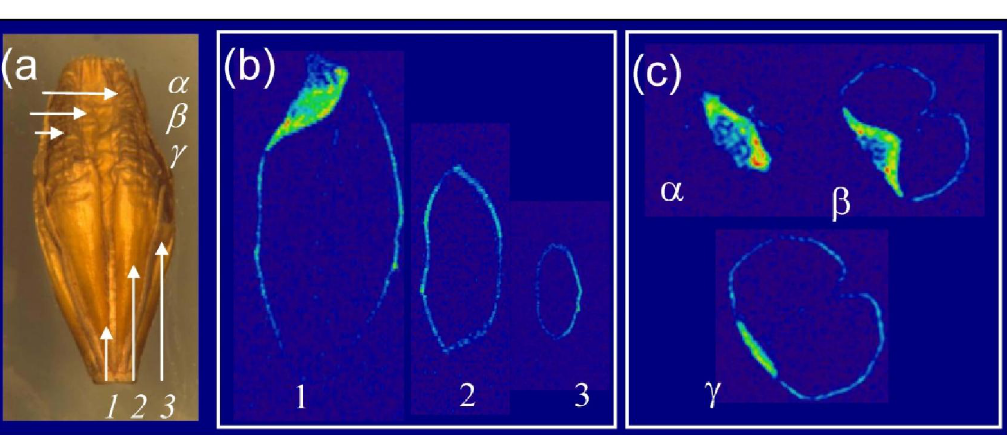
Figure 2. 1 H NMR visualization of lipids in naturally aged barley grains stored for three years. ( a ) Grain used for imaging. Arrows show the placement of the virtual sections (longitudinal 1,2,3 and cross section α, β, γ); Colour-coded visualization of lipid distribution ( b ) along the grain axis (1,2,3) and ( c ) across the cross section (α, β, γ).